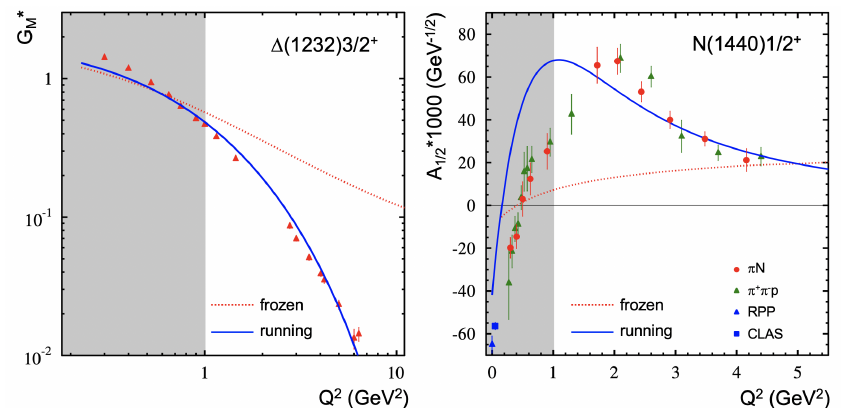
Figure 7. Description of the results for the N → ∆ magnetic transition form factor G ∗ electrocoupling amplitude A 1/2 for the N → N ( 1440 ) 1/2 + ( right ) achieved using CSMs [65,66,68,69]. Results obtained with a momentum-independent (frozen) dressed-quark mass [65,66] (dotted red curves) are compared with QCD-kindred results (solid blue curves) obtained with the momentum-dependent quark mass function in Figure 2. The electrocoupling data were taken from References [50,121,123]— π N electroproduction, and References [67,83,136,137]— π + π − p electropro- duction. The photocouplings for the N ( 1440 ) 1/2 + are from the RPP [76] and from Reference [138]— blue square and triangle, respectively. The ranges of Q 2 where the contributions from the meson– baryon cloud remain substantial are highlighted in